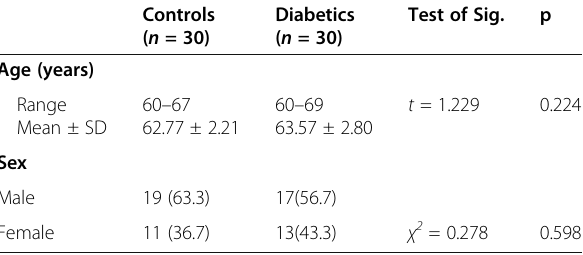
Table 1 Demographic data of diabetics and controls Controls ( n = 30)